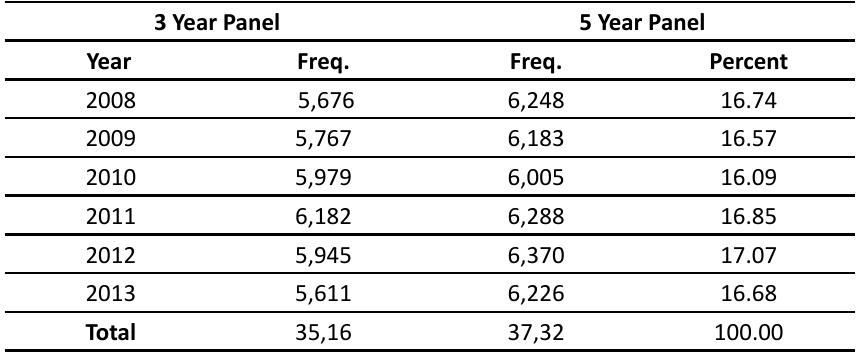
Table 2: East Java Manufacturing Distribution of Year included in The Analysis 3 Year Panel 5 Year Panel Year Freq.